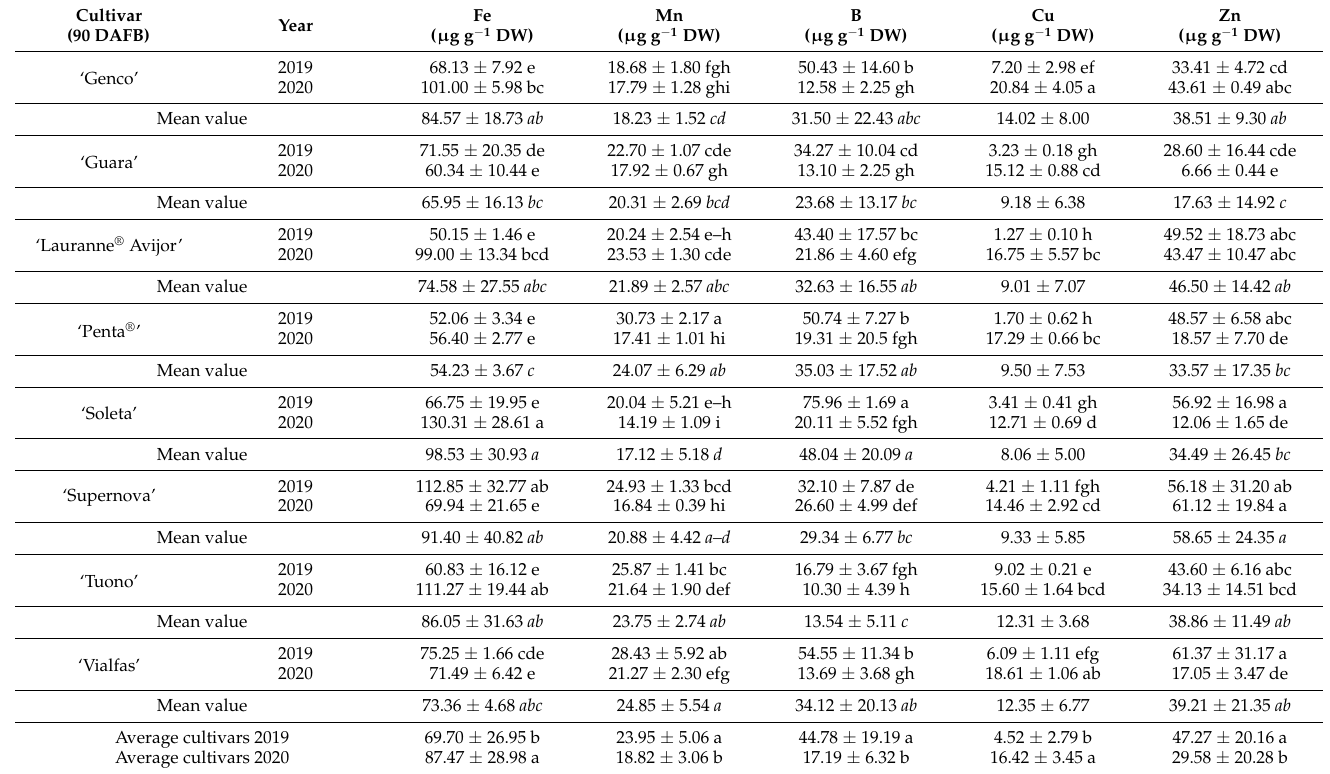
Table 4. Micronutrients content ( µ g g − 1 DW) in almond leaves collected at 90 DAFB over the years 2019–2020. (Fe = iron, Mn = manganese, B = boron, Cu = copper, Zn = zinc). Data are presented as mean ± standard deviation. Different lowercase letters on the columns indicate significant differences between means (Fisher’s test p < 0.05). Lowercase letters in italics describe the differences expressed as two-year mean values of the